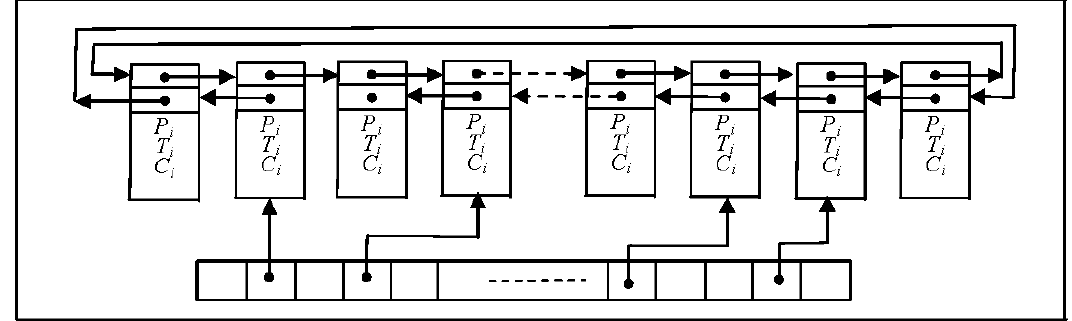
Figure 9. Hash-table on a circular double-linked list for sweep-circle clustering.